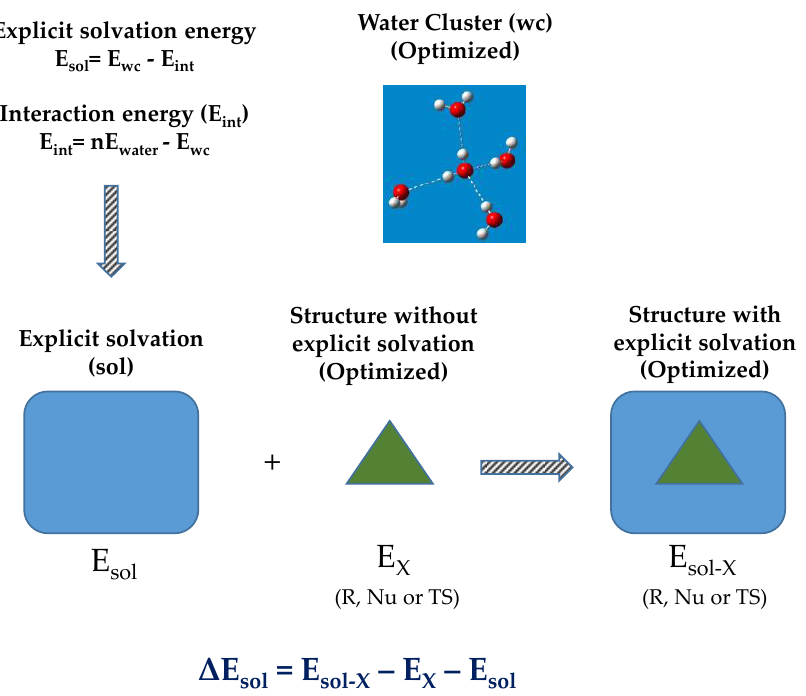
Figure 8. Schematic representation of the solvation model approach used in this work.